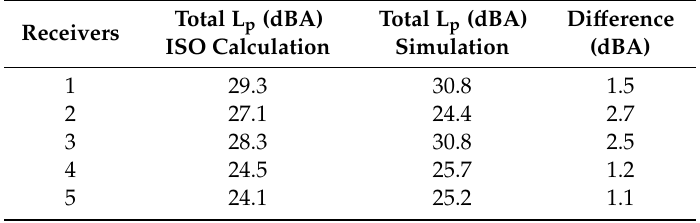
Table A4. Comparison between total SPL (dBA) numerical and ISO results at the Llumeres location